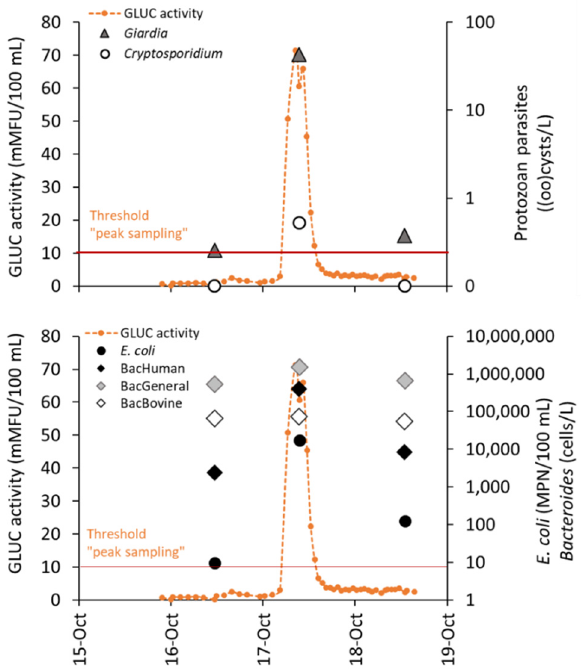
Figure 2. Detection of protozoan parasites ( Cryptosporidium , Giardia ), E. coli and Bacteroides (BacHu- man and BacBovine markers) at the GLUC activity peak using automated peak sampling triggering mode at site 2. This mode was initiated above the pre-defined GLUC activity threshold of 10 mMFU/100 mL. Before and after the GLUC activity peak (baseline activity of 2–3 mMFU.100 mL − 1 ), sample collection was triggered remotely through the online interface of the ColiMinder using a virtual private network (VPN) certificate. The manual trigger was done remotely based on real-time observation of GLUC activity measurements on the online interface.